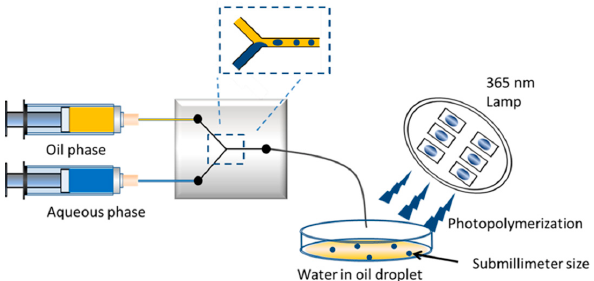
Figure 4. The submillimeter sized MIP-based microgels preparation. Republished with